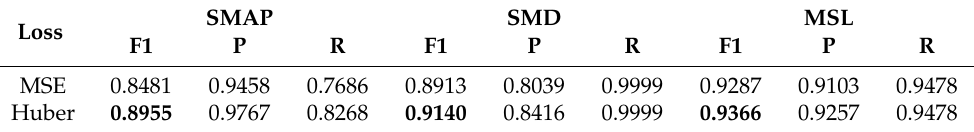
Table 5. The effects of Huber Loss. The best results are highlighted in bold.